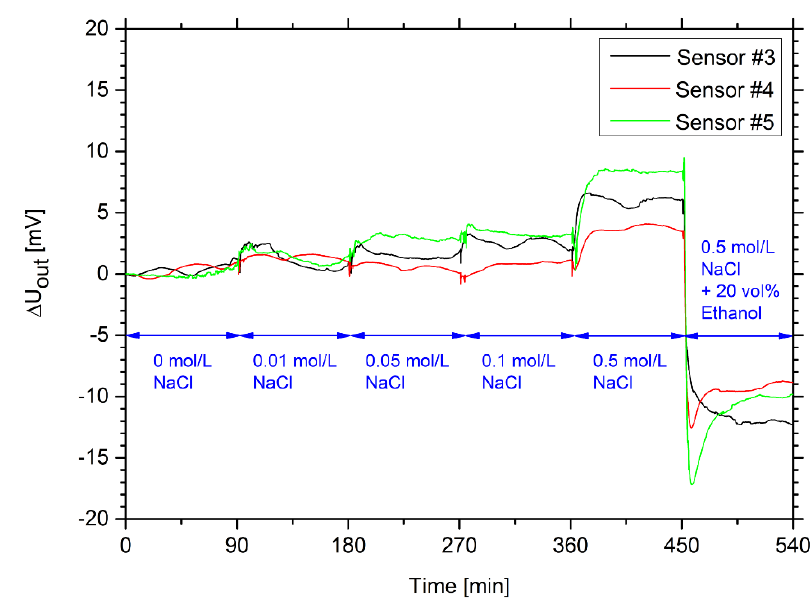
Figure 5. Time-dependent change of the output voltage for three hydrogel-based sensors in ethanol-free solutions with different values of the ionic strength, in a range from 0.01 to 0.5 mol/L. To underline the ethanol sensitivity of the sensors, a solution with 20 vol% ethanol and 0.5 mol/L sodium chloride was measured at the end of the experiment.